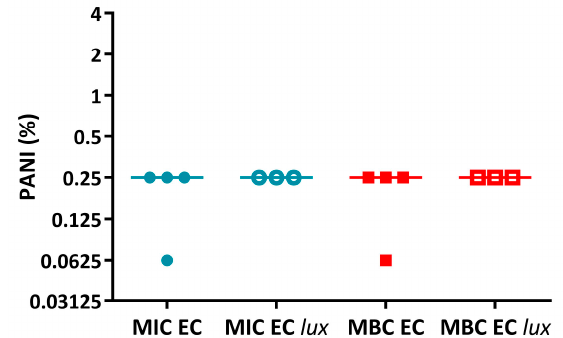
Figure A1. Activity of PANI against E. coli 25922 and E. coli 25922 lux . The MIC (circles) and MBC (squares) of PANI against E. coli 25922 (EC) and E. coli 25922 lux (EC lux ) in LB broth. Data obtained from E. coli 25922 is represented by filled data points while data obtained from E. coli 25922 lux is represented by unfilled data points.